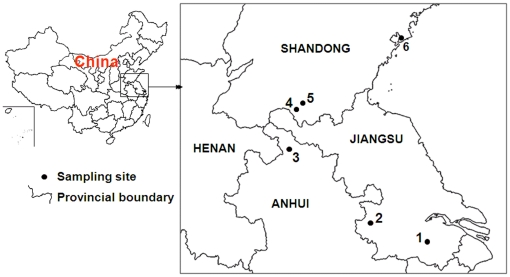
Map of China showing the distribution of mosquito sampling sites.1, Wuxi (31°33′58.47″N, 120°18′9.88″E); 2, Nanjing (32°3′30.11″N, 118°47′47.28″E); 3, Huaibei (33°57′13.67″N, 116°47′56.95″E); 4, Weishan (34°48′25.40″N, 117°7′43.69″E; 5, Tangkou (34°52′34.97″N, 117°22′53.69″E); and 6, Qingdao (36°3′58.85″N, 120°22′57.98″E).